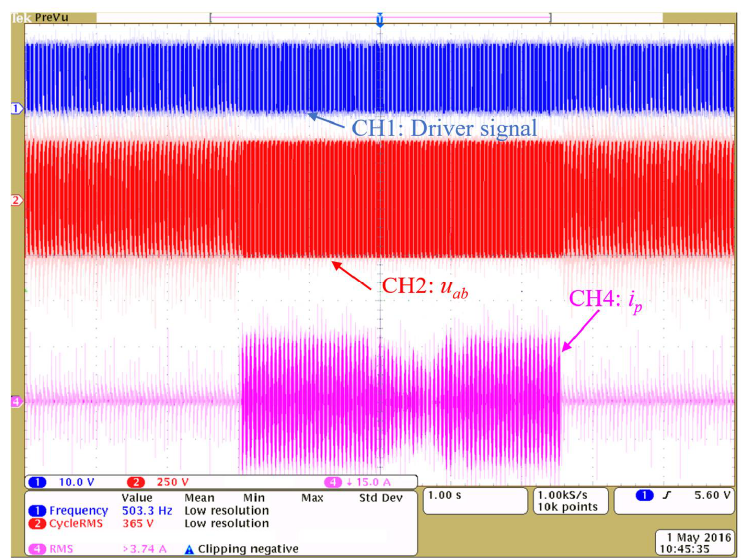
Figure 16. Power regulation process for one primary resonant network. CH1: One driver signal for inverter; CH2: Output voltage of the inverter, u ab = 365 V; CH4: Primary pad current.